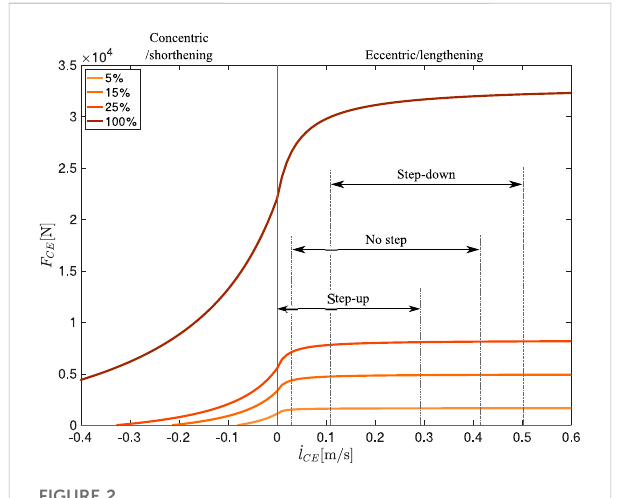
FIGURE 2 Force-velocity relation for the contractile element for